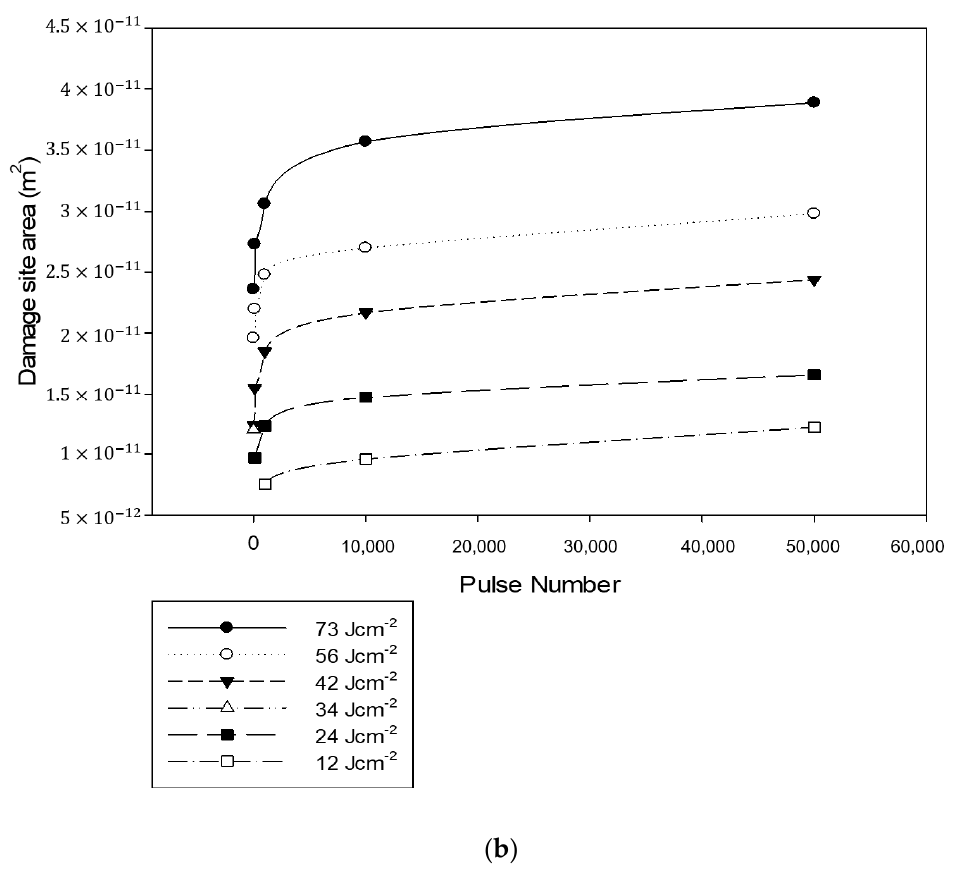
Figure 6. Graphs showing the laser-modified site area as a function of the pulse number for various fluences for ( a ) diamond and ( b ) sapphire for surface modification.